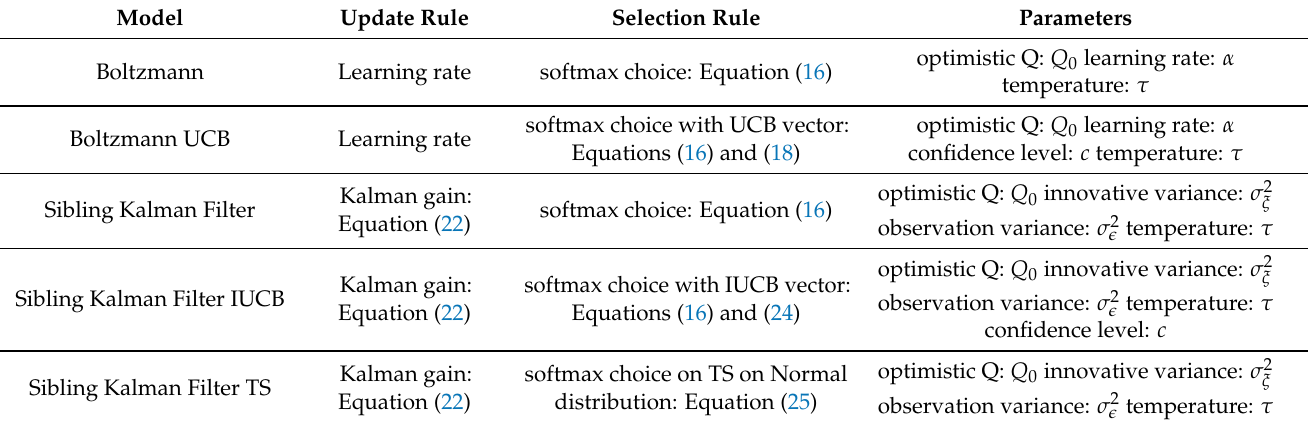
Table 3. The models for comparative